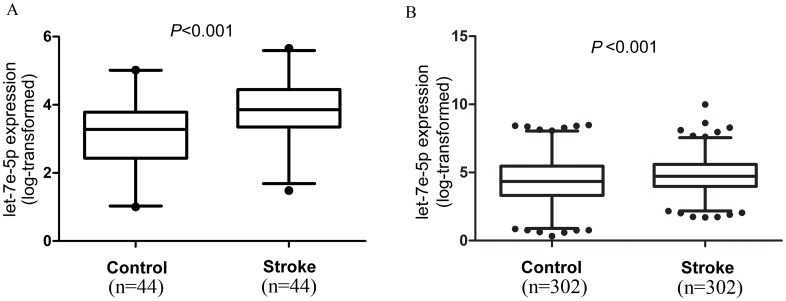
The expression levels of let-7e-5p in stage I and II populations.Let-7e-5p expression was detected in (A) stage I (n = 44 patients and controls) and (B) stage II (n = 302 patients and controls) population. The relative expression levels were normalized to U6 and then log-transformed. The whiskers of the plots represent the 2.5 to 97.5 percentiles.